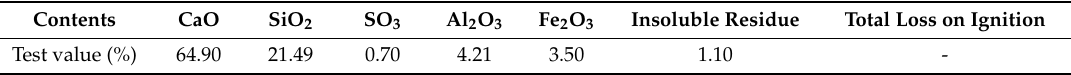
Table 1. Chemical composition of Ordinary Portland Cement.